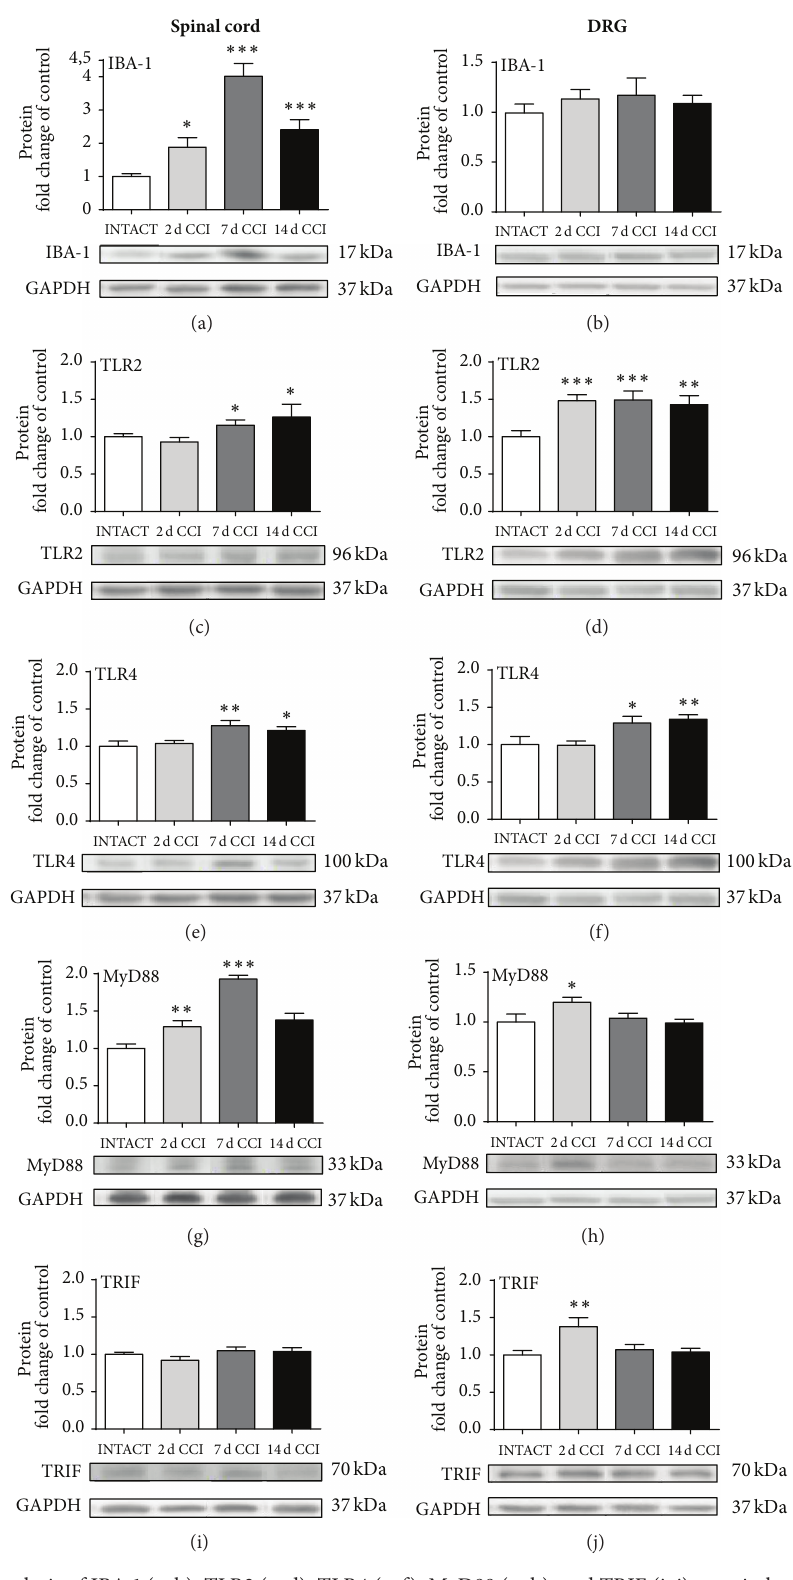
Figure 3: Western blot analysis of IBA-1 (a, b), TLR2 (c, d), TLR4 (e, f), MyD88 (g, h), and TRIF (i, j) protein levels in the ipsilateral dorsal lumbar spinal cord (a, c, e, g, and i) and DRG (b, d, f, h, and j) tissue on 2nd, 7th, and 14th days after chronic constriction injury (CCI) in rats. The data are presented as the mean ± SEM of 4–7 samples per group. Intergroup differences were analyzed using one-way ANOVA followed by Bonferroni’s multiple comparisons test. ∗ 𝑝 < 0.05 , ∗∗ 𝑝 < 0.01 , and ∗∗∗ 𝑝 < 0.001 indicate significant differences versus the INTACT